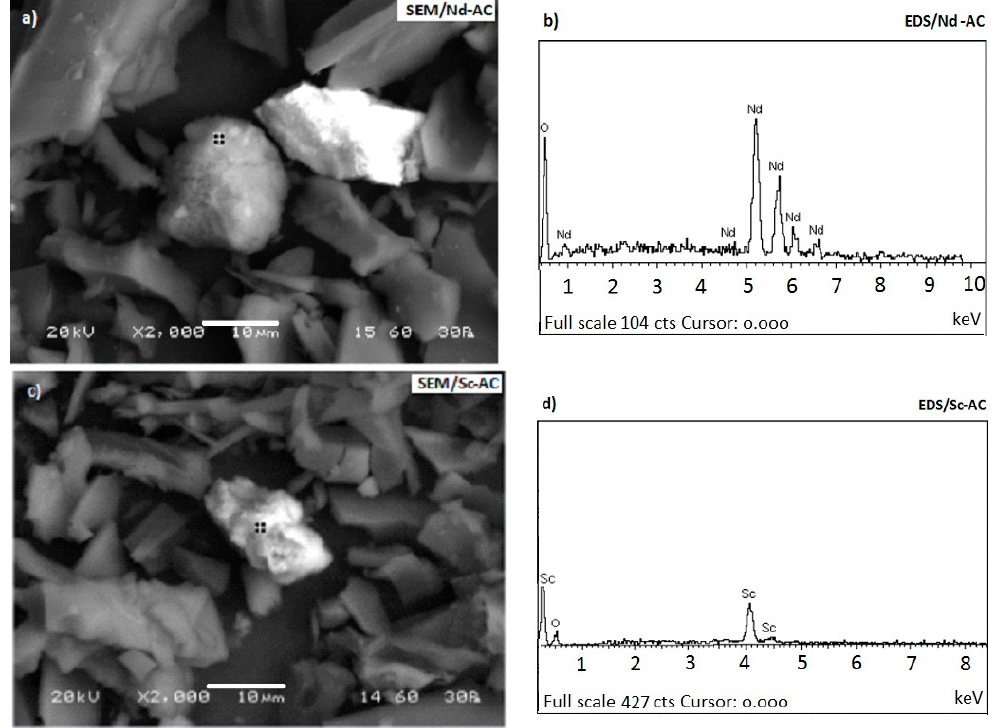
Figure 8. SEM micrographs at 2000 × and corresponding EDS spectra of AC after Nd ( a , b ) and Sc ( c , d ) adsorption, respectively.